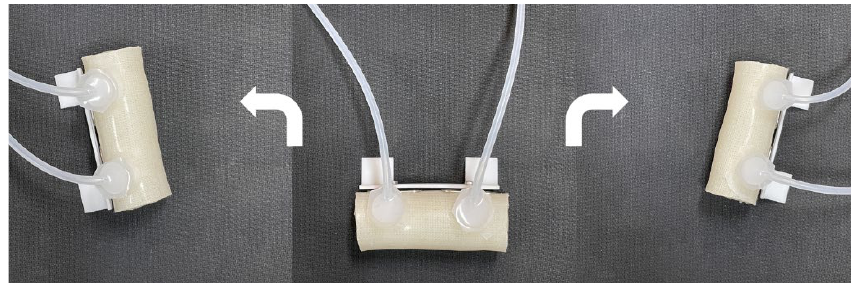
Figure 16. Rotation drive of the soft jumping robot.